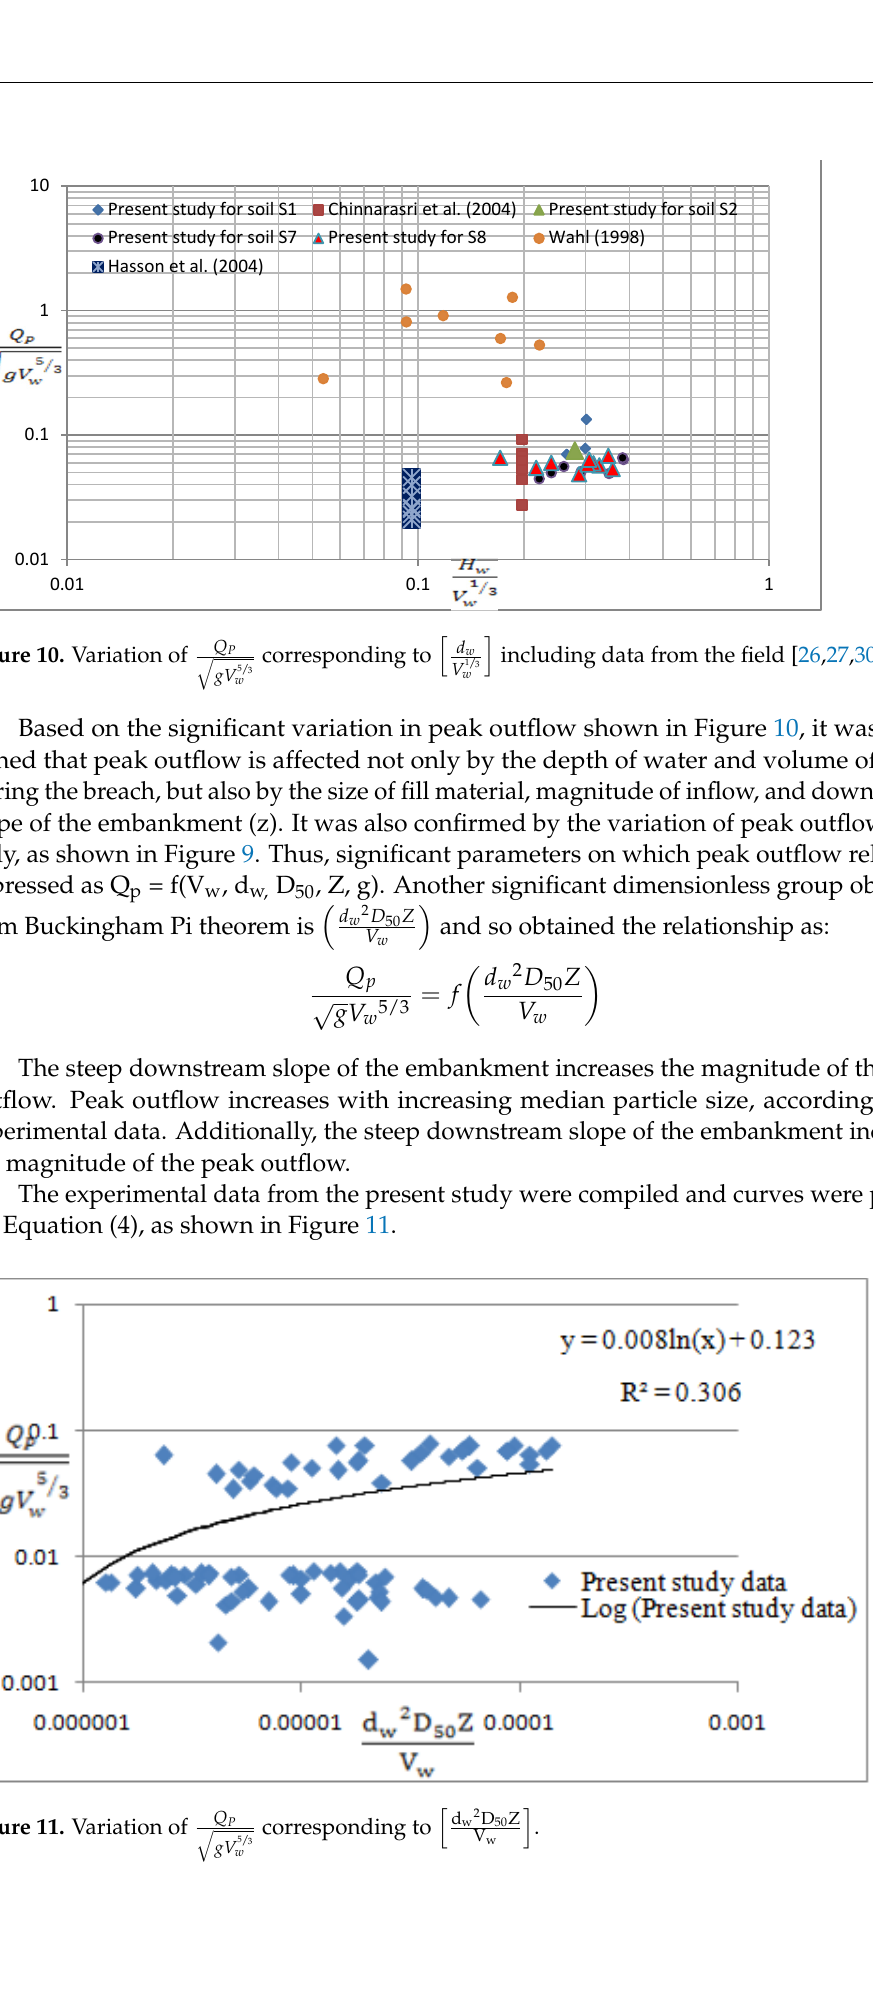
Figure 10. Variation of 𝑸 𝑷 (cid:113)